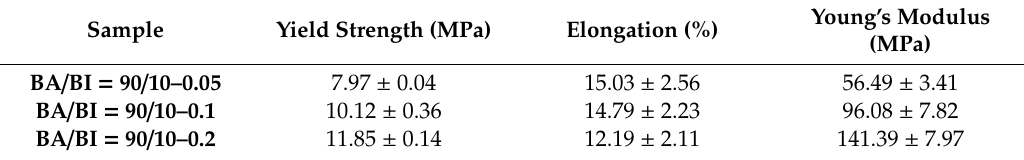
Figure 14. The stress–strain curves of PBABI copolyesters at different concentrations of BTCA. Table 9. Mechanical properties of PBABI copolyesters.